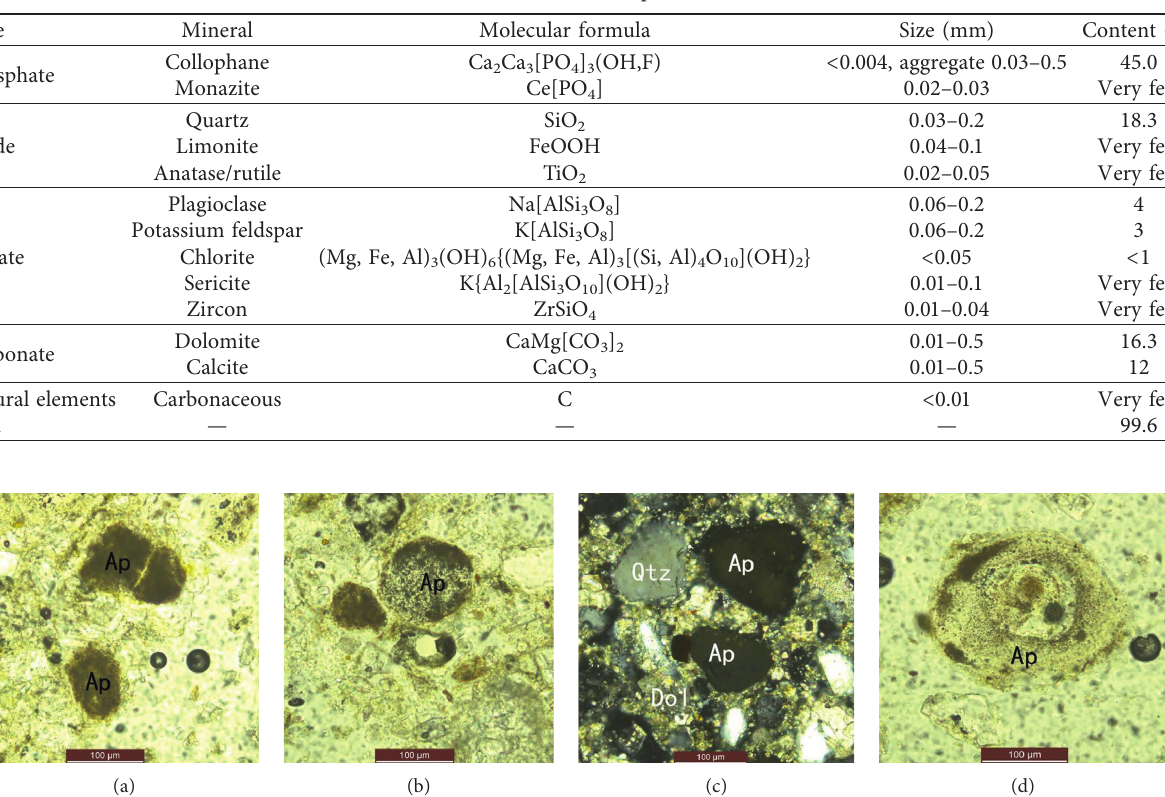
Figure 3: Embedded characteristics of phosphate (TSPL represents transmitted single polarized light). (a) Clastic collophane (Ap), TSPL. (b) Clastic collophane (Ap), TSPL. (c) Collophane (Ap) and dolomite (Dol) connected, TSPL. (d) Oolitic collophane (Ap),